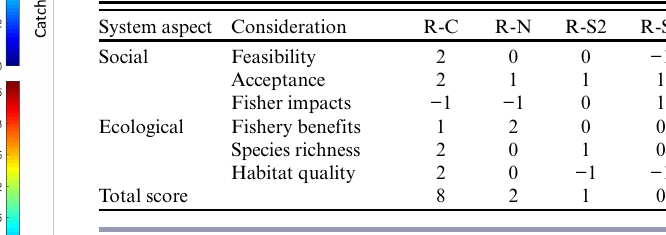
Table 2. Scores for social and ecological considerations at all community-proposed reserve locations. The order of reserves is based on total scores across all considerations. Abbreviations: R = reserve, C = central, N = north, S =